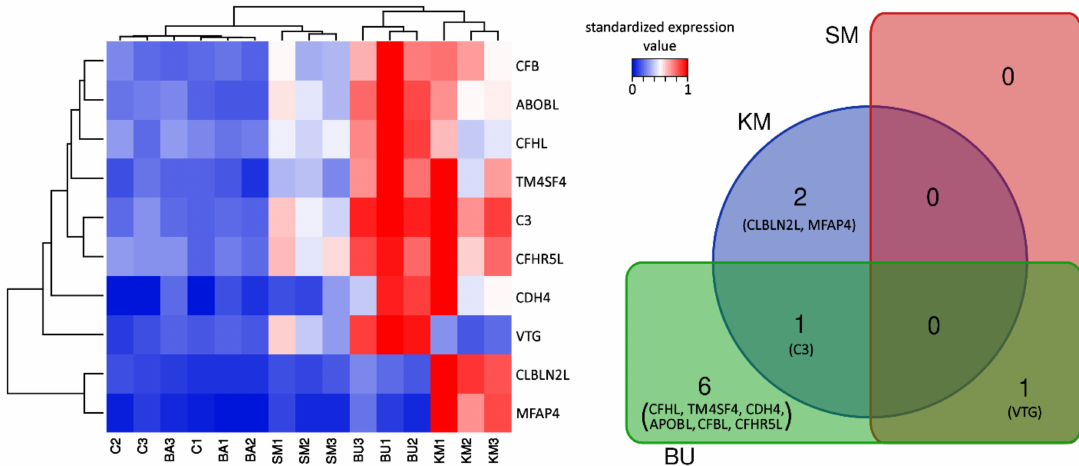
Figure 1. Heat map summarizing the expression levels of the 10 DEGs identified across the 5 experimental groups, and the overlap between di ff erentially expressed genes in response to the diets. C: control diet; KM: krill meal-rich diet; SM: soybean meal-rich diet; BA: Bactocell ® -rich diet; BU: butyrate-rich diet. See the main text for the acronyms of the gene names. Hierarchical clustering, based on the Euclidean distance and average linkage, was applied to genes and samples, which included three biological replicates. Clustering was based on the TPM expression values, standardized on the sample achieving the highest expression levels. Dendrograms close to the X and Y axes show the similarity of the expression trends among samples and genes, respectively. DEGs: Di ff erential Gene Expression; TPM: Transcripts Per